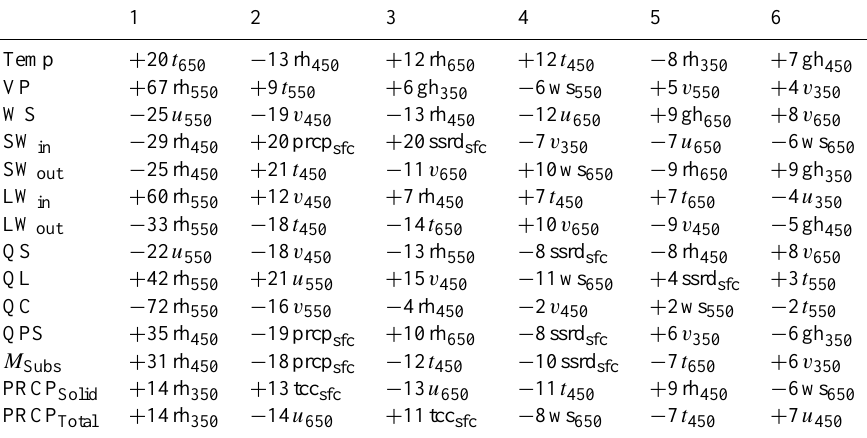
Table A1. The six most important predictors and their coefficients (normalized in %) for each downscaled variable at 4750 m